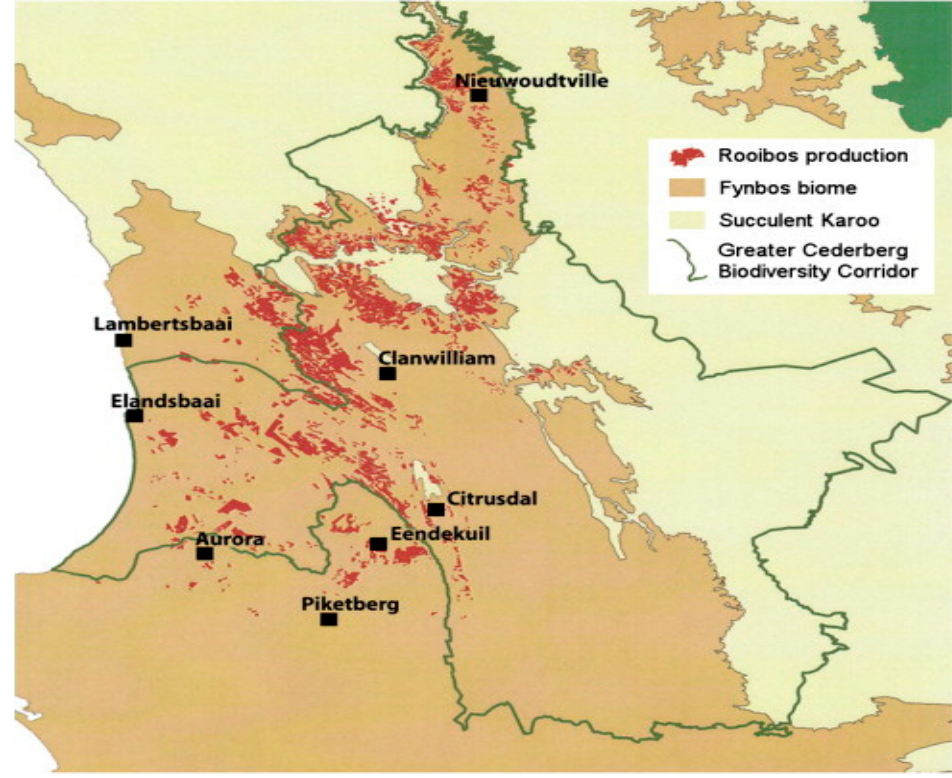
Figure 2. The production area of rooibos [4] (map extracted from SARC) .